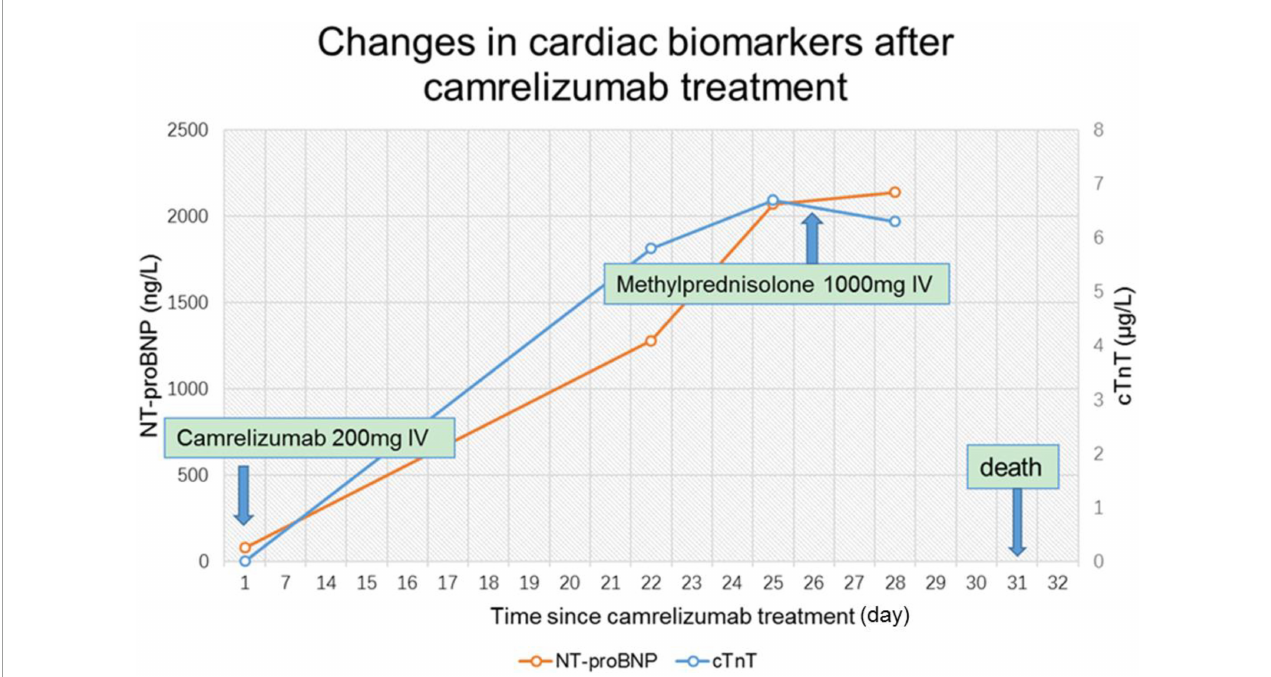
FIGURE4 Changes of cardiac biomarkers in patients with acute myocarditis before and after immune checkpoint inhibitors (ICI) treatment. cTnT, cardiac troponin T; NT-proBNP, N-terminal pro brain natriuretic peptide.